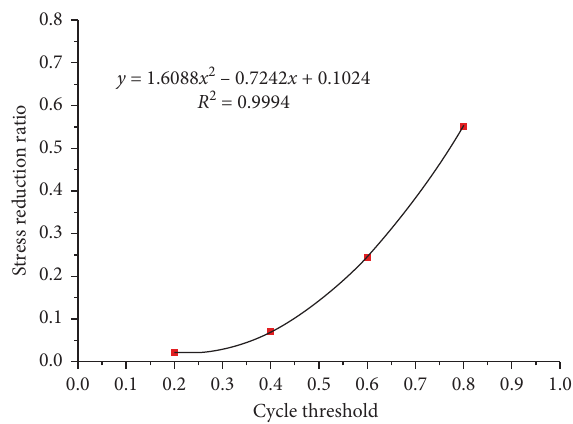
Figure 6: The relationship between stress reduction ratio and damage degree of